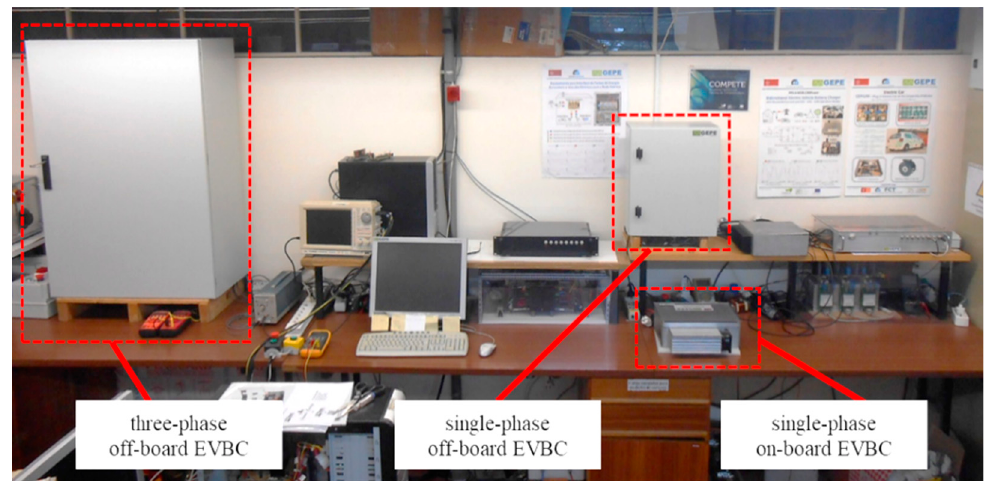
Figure 21. Photography of the laboratory workbench with the on-board and off-board EVBCs.